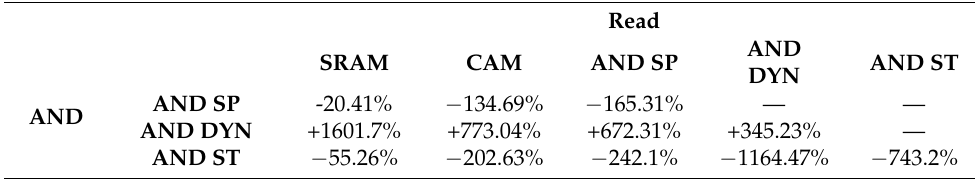
Table 13. Percentage differences in the read and AND energy–delay products among the arrays. Each value corresponds to the increase, expressed in percentage, in the energy–delay product of the memory on the corresponding row with respect to the one of the memory on the corresponding column. The data are extracted from Table